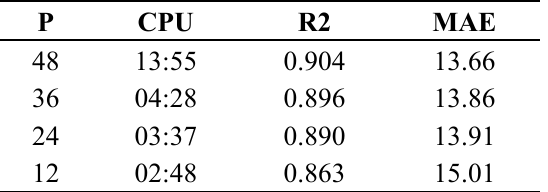
Table 9. Comparison between different P’s when Q = 97 (Fisk, fall).